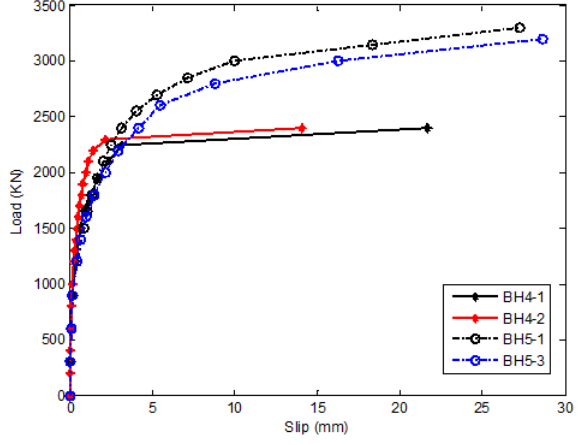
Figure 19. Load–slip relationship. Figure 19. Load – slip relationship.